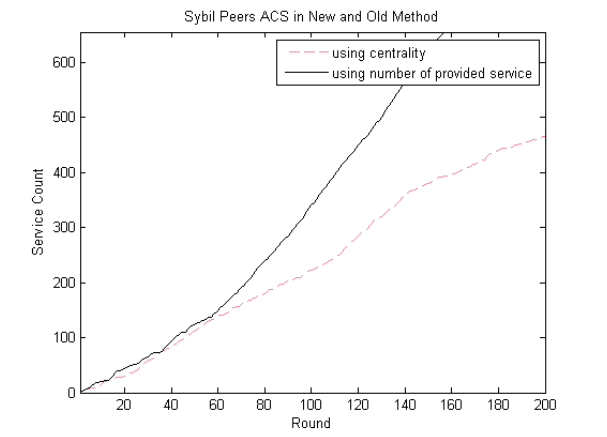
Figure 4. Effect of centrality.